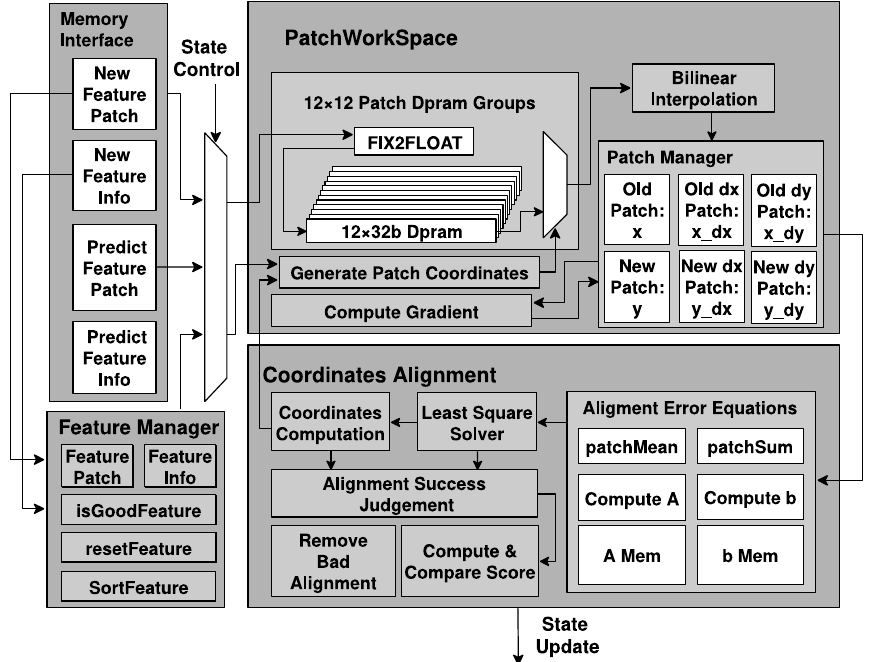
Figure 8. Detailed structure of the feature processing engine.